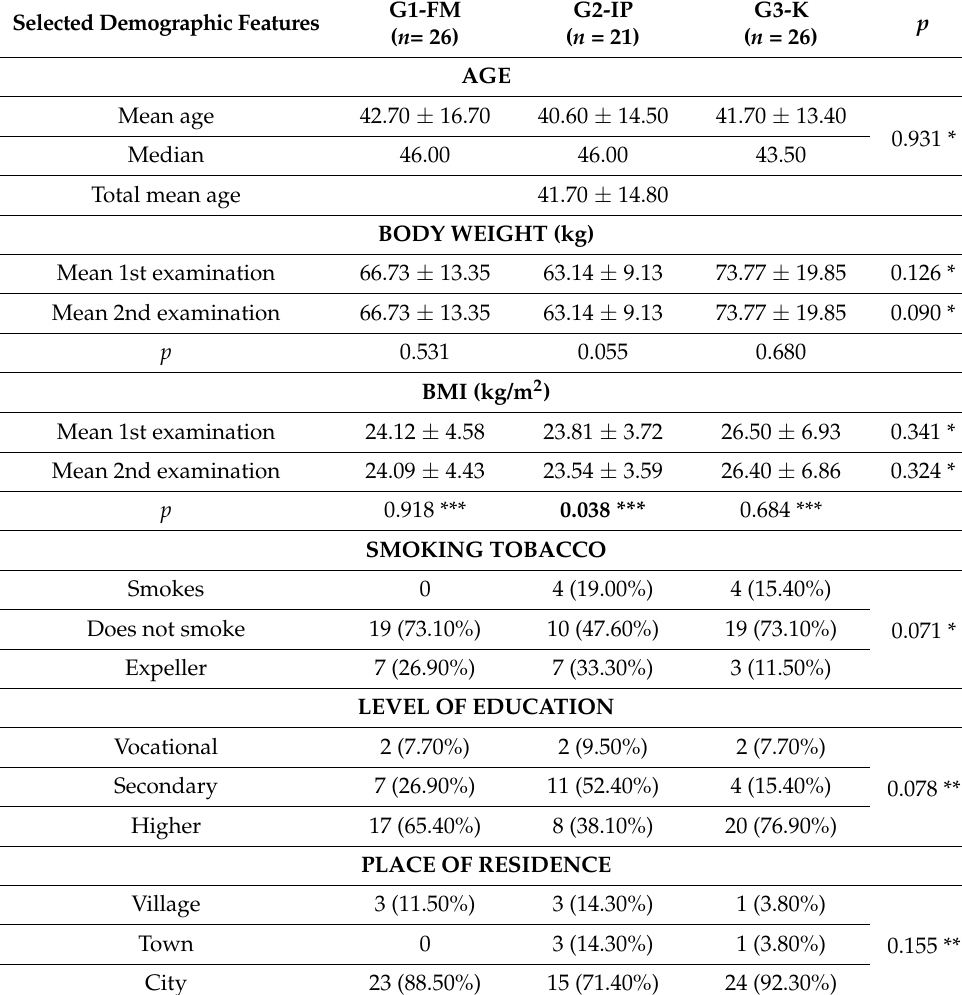
Table 1. Demographic characterization of the patients. Selected Demographic